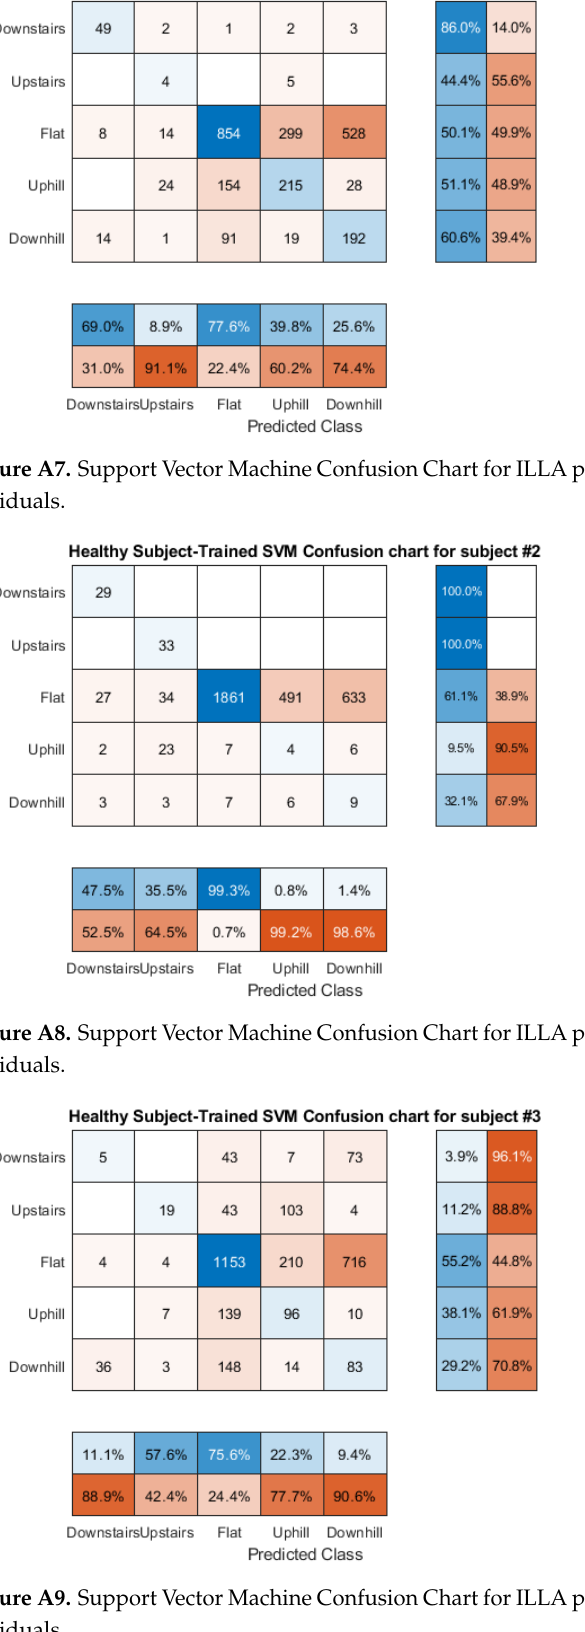
Figure A9. Support Vector Machine Confusion Chart for ILLA participant A3 as trained by healthy in-